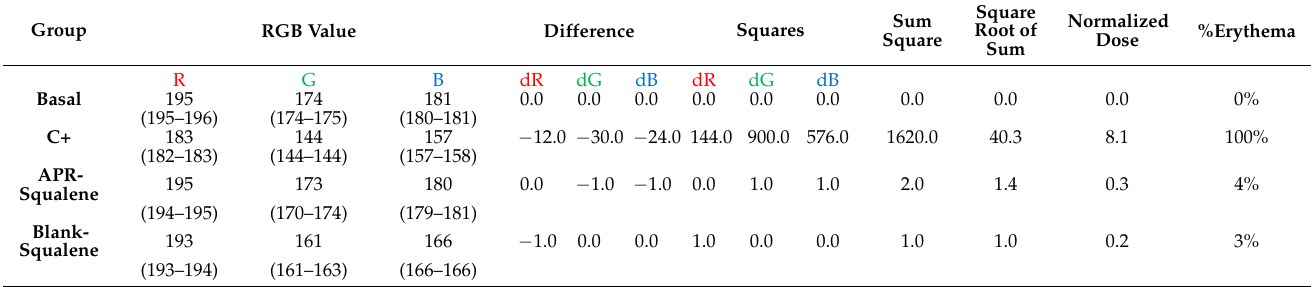
Table 8. Skin color measurements expressed in RGB code of APR-Squalene and Blank-Squalene solutions. Measurements were made in the established quadrants of the dorsal area of the